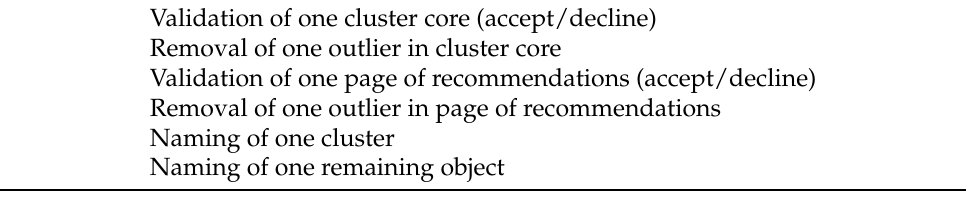
Table A1. Actions that are counted as one click in the simulation.